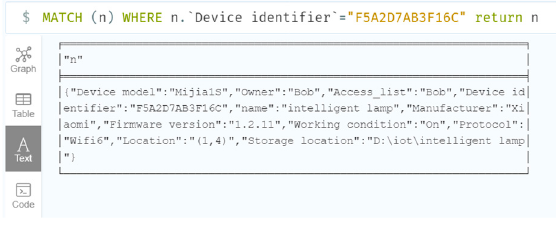
Figure 14. The device identification information query.